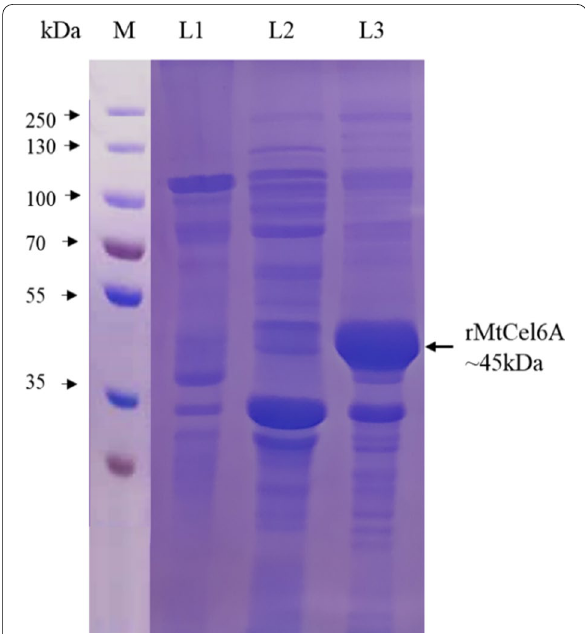
Fig. 2 Production of rMtCel6A under optimum conditions. The protein samples loaded on 12% SDS PAGE; M: protein marker; L1: Empty vector (without construct) L2: rMtCel6A (supernatant); L3: rMtCel6A (pellet). [Protein ladder (PageRuler Plus prestained) was procured from Thermo